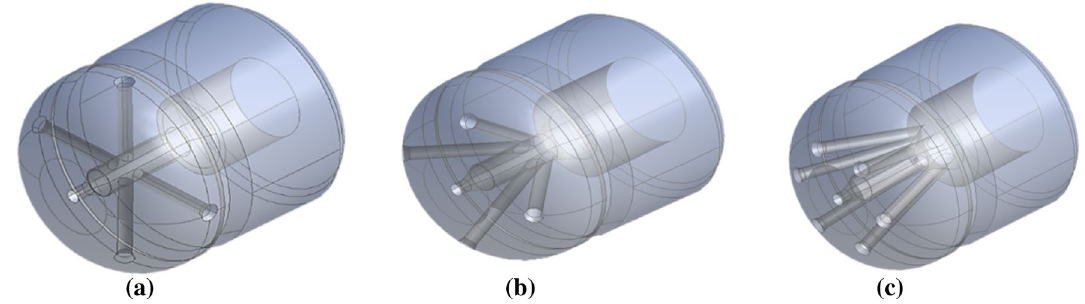
Fig. 3 CATIA design of the selected nozzle; a nozzle with 1port@0°_4ports@90° design configurations, b nozzle with 1port@0°_4ports@45°